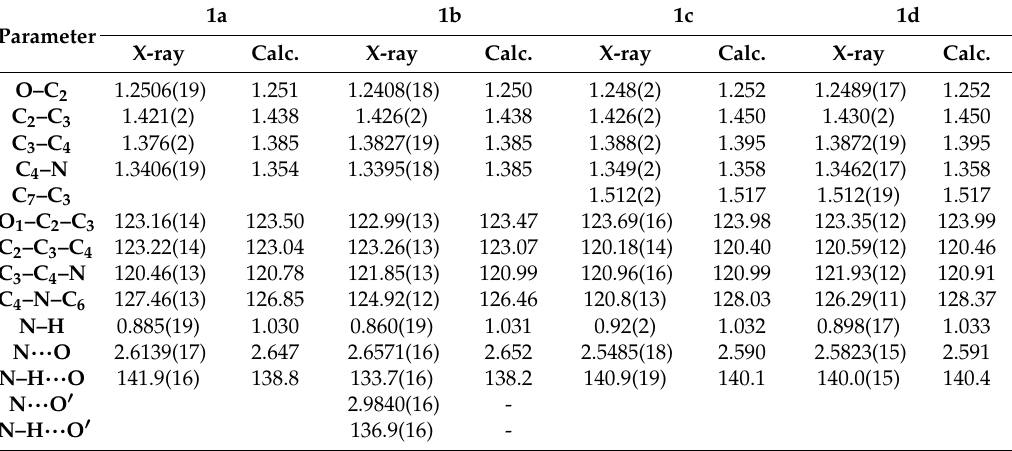
Table 1. Experimental 1 and calculated 2 bond lengths (Å) and angles (°) for 1a – d .